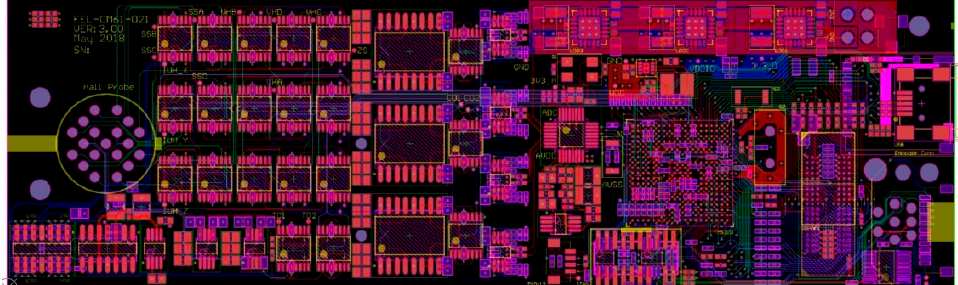
Figure 3. Artwork of the 8 layer PCB (Printed Circuit Board) showing the 4 signal layers and the silkscreen.